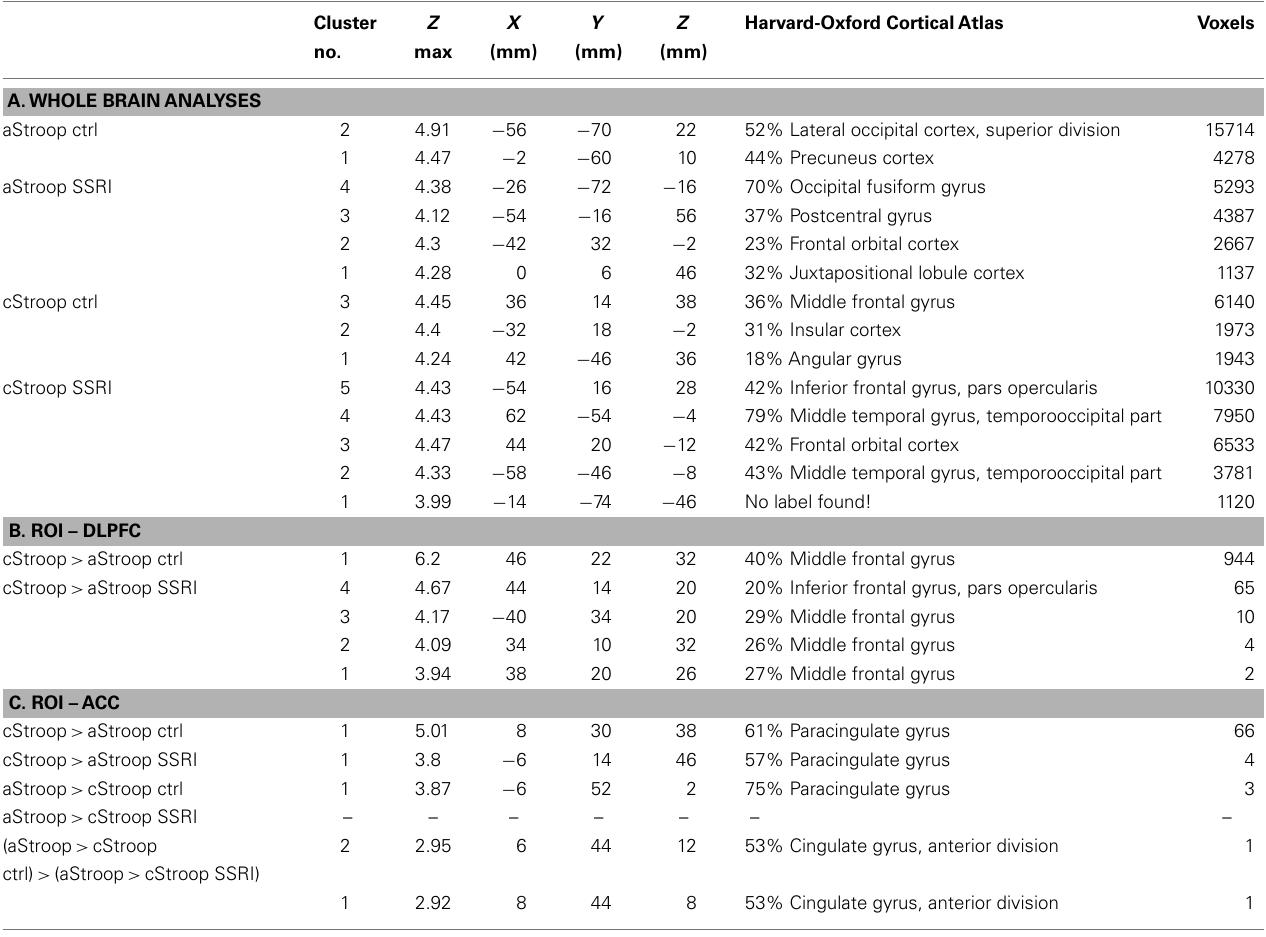
Table 1 | Cluster